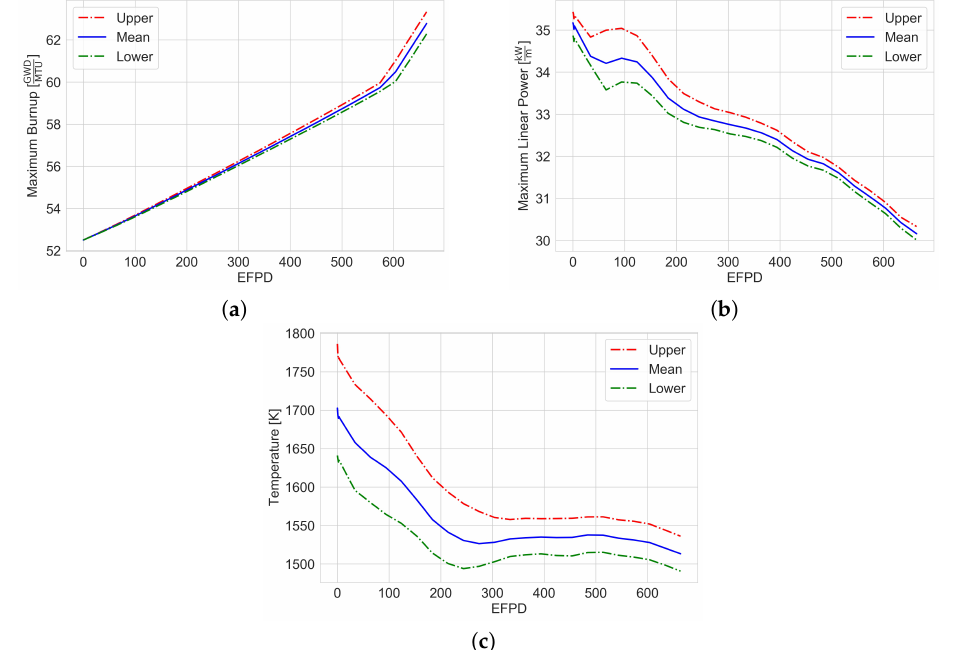
Figure 39. Evolution over depletion of the ( a ) Bu max